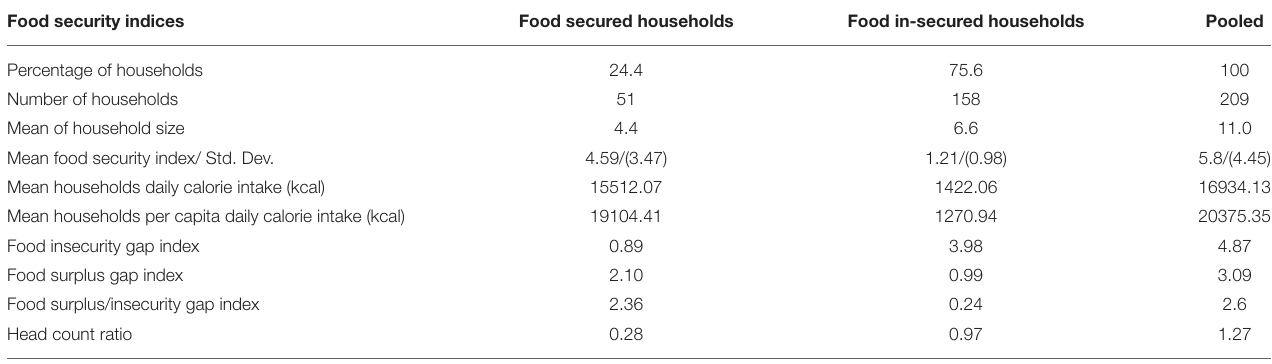
TABLE 8 | Food security indices of households during COVID-19. Food security